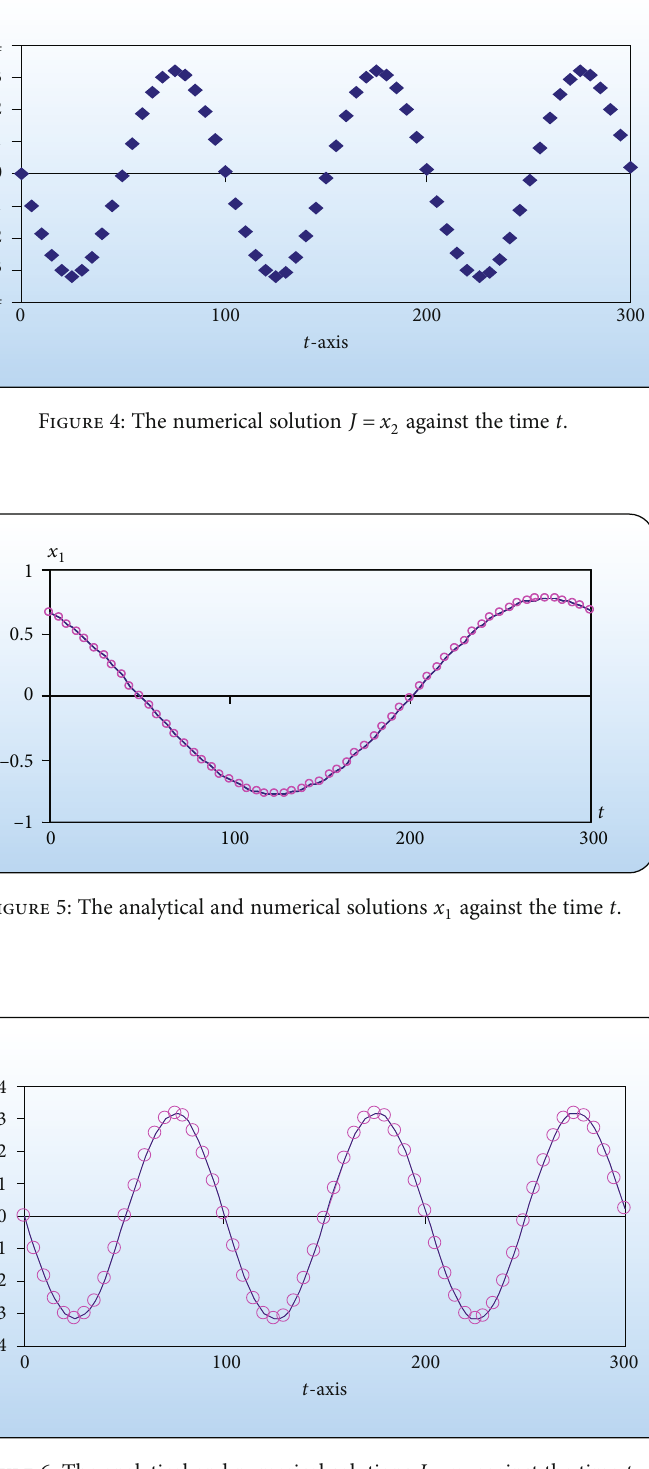
2 against the time t